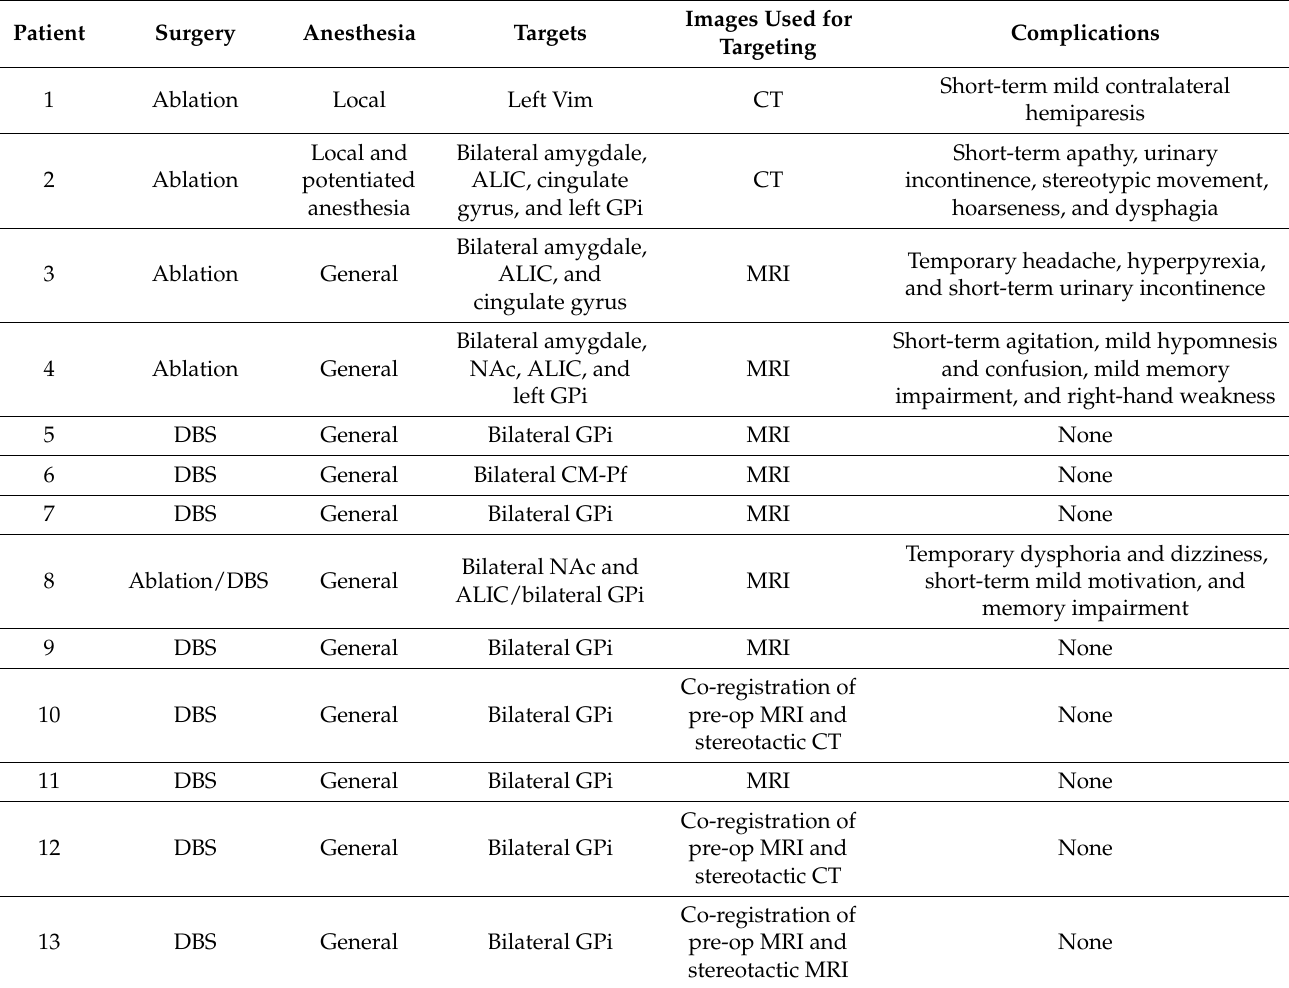
Table 2. Details of the surgical procedures in the thirteen TS